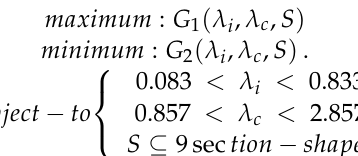
Figure 9. Effect of axial length of contraction section on nozzle performance. maximum : G 1 ( λ i , λ c , S